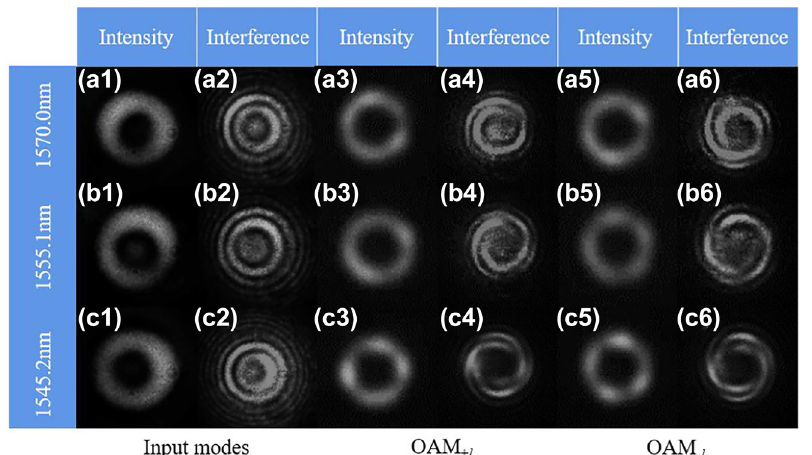
Figure 11: The input and output OAM mode profiles and interferences with Gaussian beam for (a) the 1-order, (b) the 2-order and (c) the